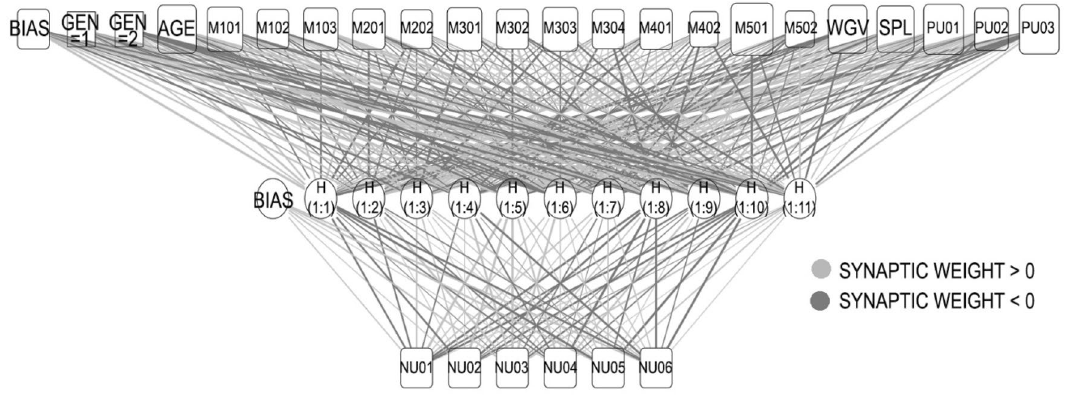
Figure 3. ANN graphic